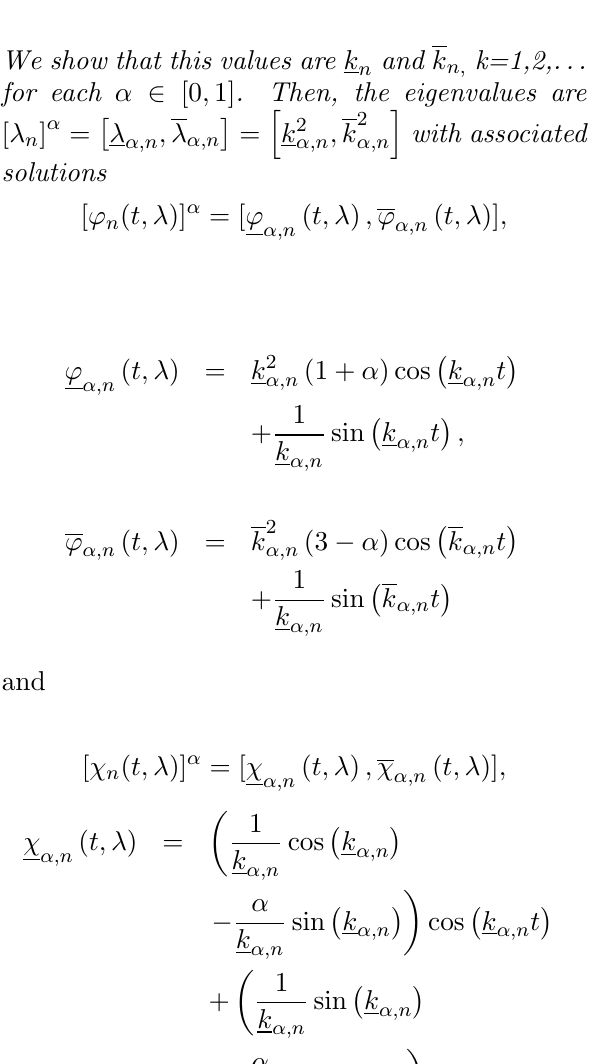
( t, λ ), Blue α,n ( t, λ ) = 1 ,n